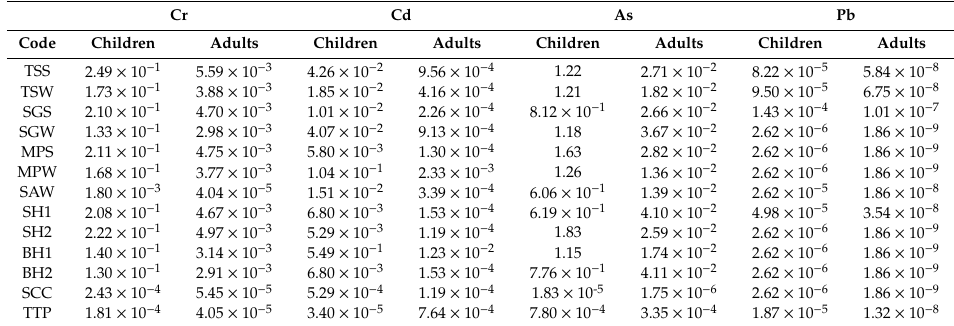
Table 8. Carcinogenic risk assessment of Cr, Cd, As and Pb, from geothermal springs and boreholes within Soutpansberg, through the ingestion pathway for adults and